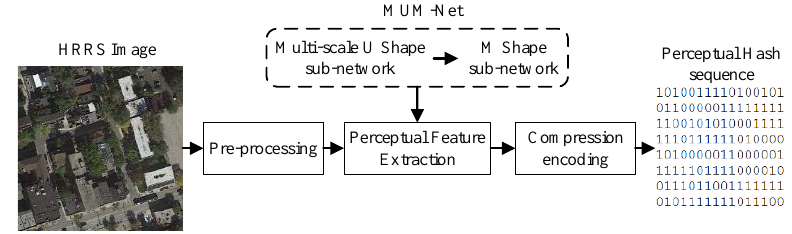
Figure 3. Overview of the proposed perceptual hash algorithm.